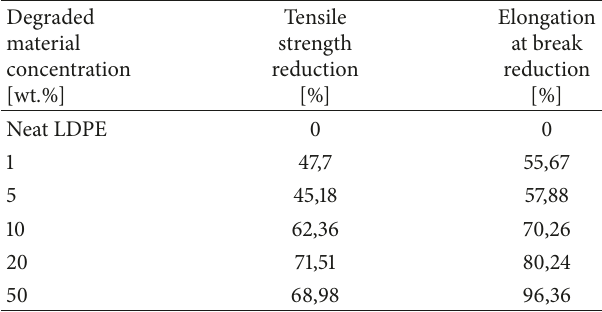
Table 2: Reduction of the mechanical properties of degraded material/LDPE blends compared to the neat LDPE.